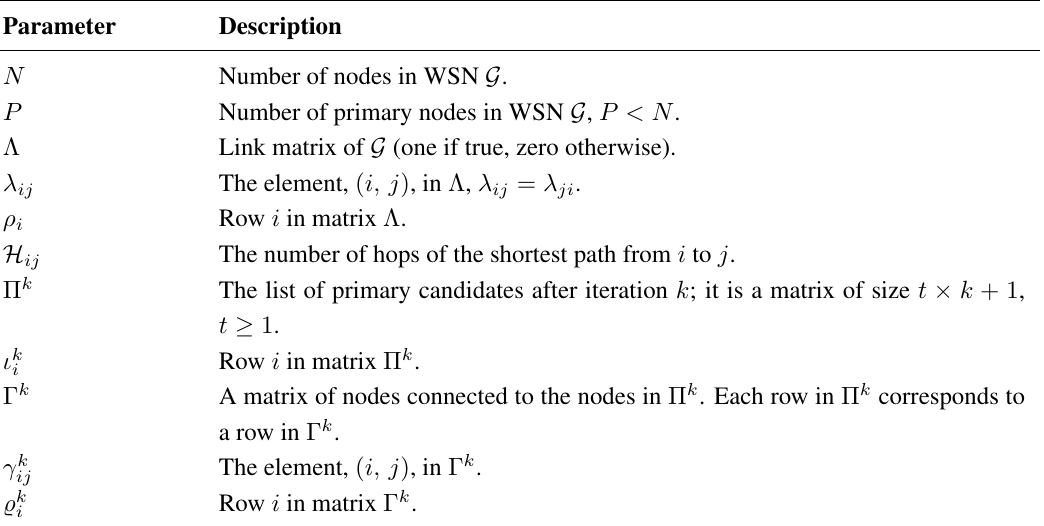
Table 4. OPT-PRIM algorithm